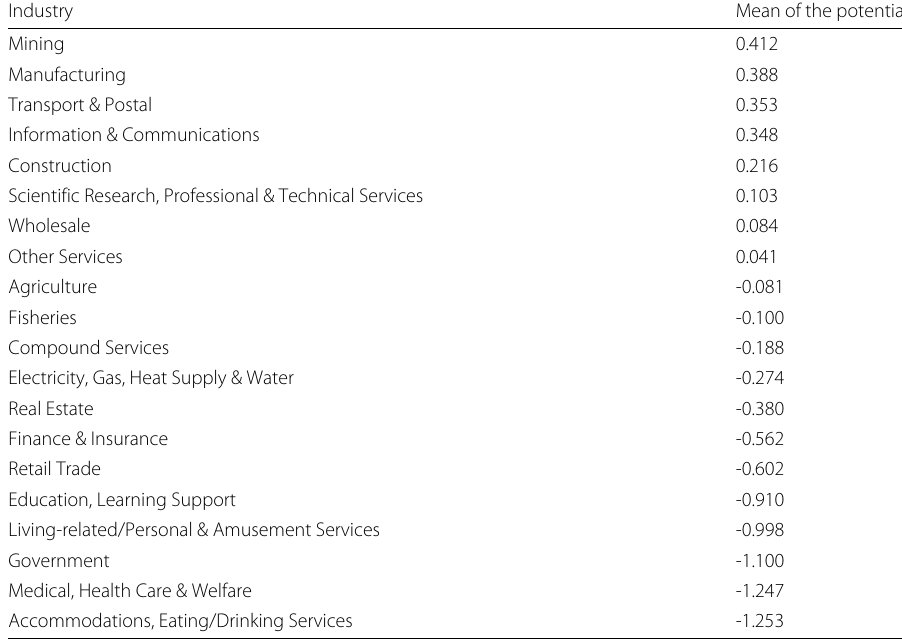
Table 2 The averaged values of the Helmholtz-Hodge potential for firms in individual sectors, which are listed in their descending order corresponding to the direction of upstream to downstream in the TSR transaction